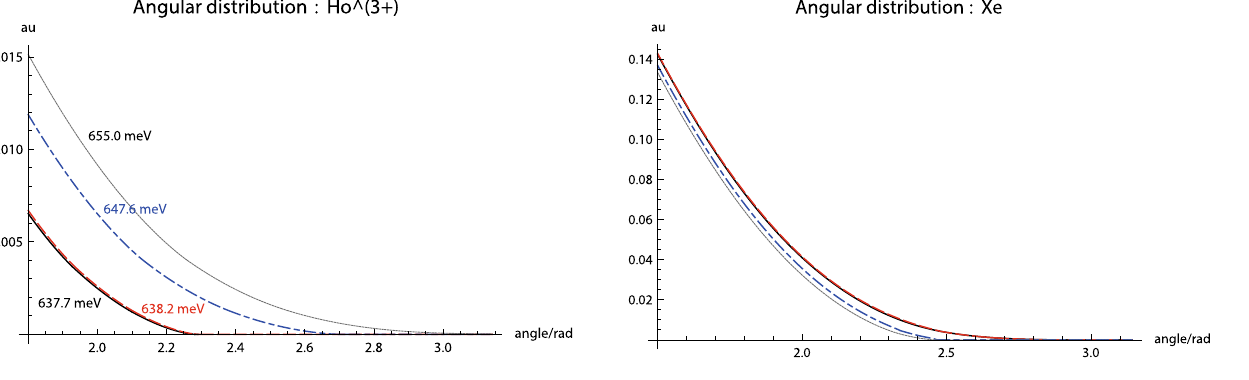
Fig. 9 Xe RANP angular distribution with r = 0 . 32304. Cases of NO Majorana of smallest neutrino mass 1 meV in solid black, NO Majorana of 50 meV in dotted black, NO Dirac 1 meV in dashed red, and NO Dirac 50 meV in dash-dotted blue. The absolute rate is obtained by multiplying a factor 0 . 12s − 1 assuming n 3 V η = ( 10 17 ) 3 cm −